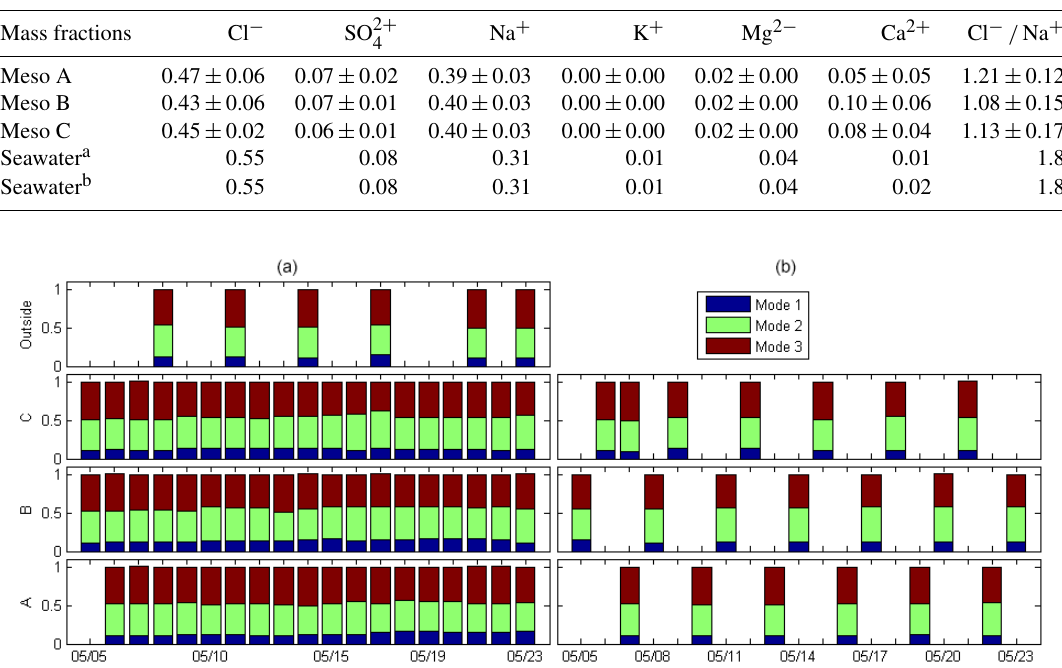
Table 3. Mass fractions of the main inorganic components in sea spray (PM 1 ) to the total inorganic mass measured from impactor samples on PMA generated from six samples per mesocosm, and mass fraction of the main inorganic ions in seawater reported by a Seinfeld and Pandis (1997) and b Pilson (1998).